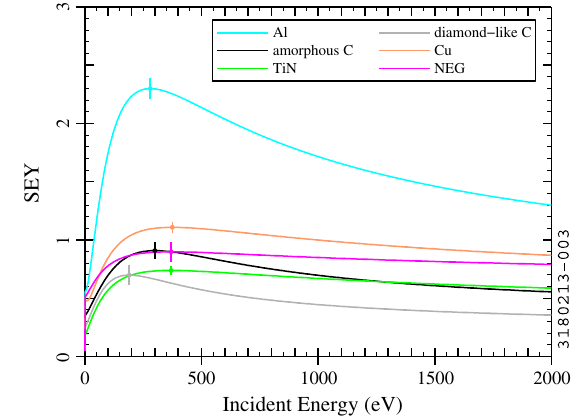
FIG. 6. Secondary electron yield curves (at normal incidence) generated by the best fit parameters for each chamber (Table VII). Error bars are shown for the peak yield values ( DTOTPK